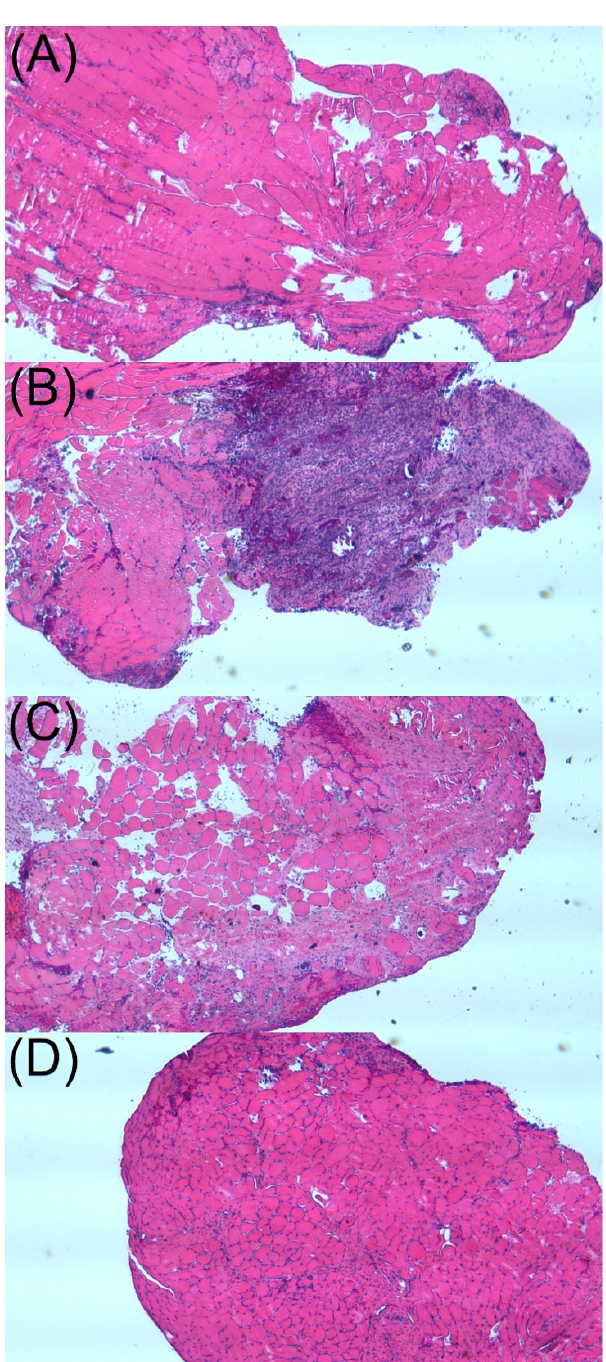
Figure 8. Histological analysis of muscle tissue surrounding the biodegradable membrane at ( A ) 1, ( B ) 7, ( C ) 14 and ( D ) 28 days post-implantation (200×). Microscopic examination of hematoxylin and eosin-stained specimens showed significant mononuclear cell infiltrates of lymphocytes, plasma cells, and eosinophils in the muscle tissue surrounding the membrane at day 7 after surgery. The number of polymorphonuclear leukocytes gradually decreased over time up to day 28 post-surgery.